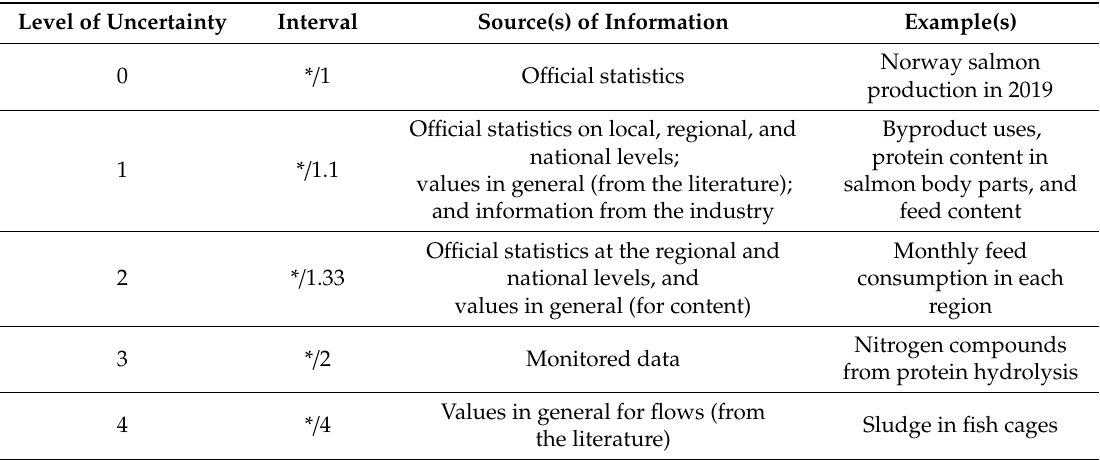
Table 2. Uncertainty intervals and data